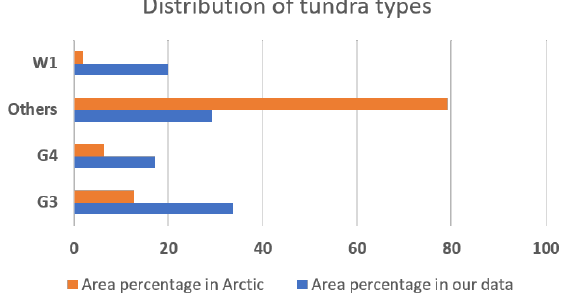
Figure 4. Distribution of tundra